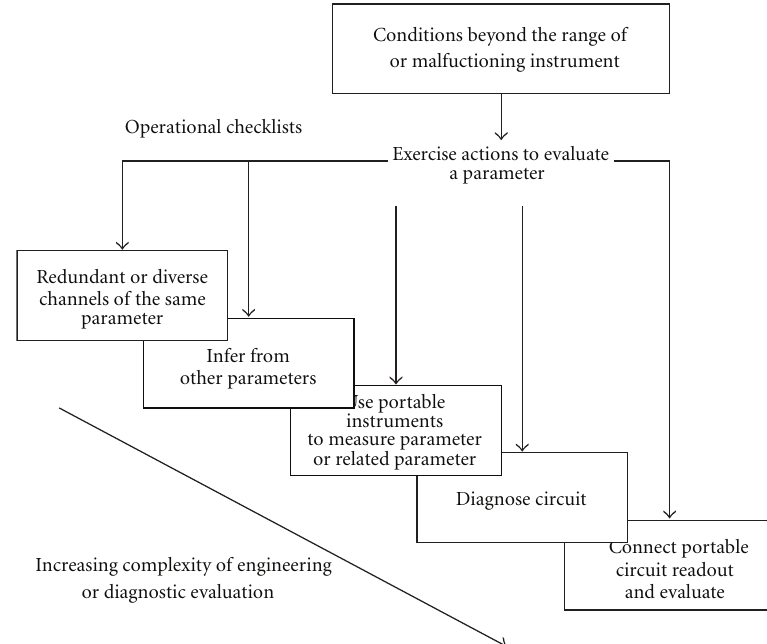
Figure 1: Flowchart for the circuit diagnosis methods among the five types of aids.